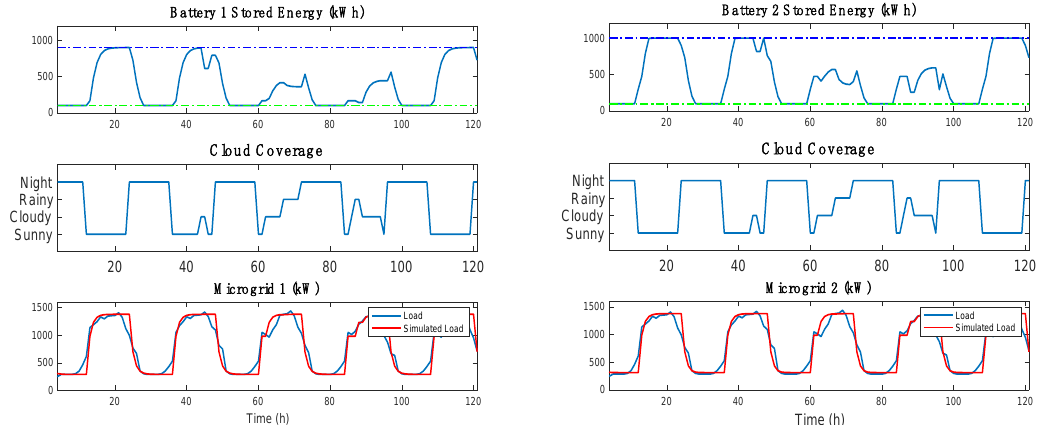
Figure 8. Simulation results when µ Grids 1 and 2 are islanded: battery energy variation ( top figure), cloud coverage (middle figure) and load power usage (bottom figure). The green and blue dashed lines represent the 10% and 90% of the minimum and maximum battery energy storage, respectively.